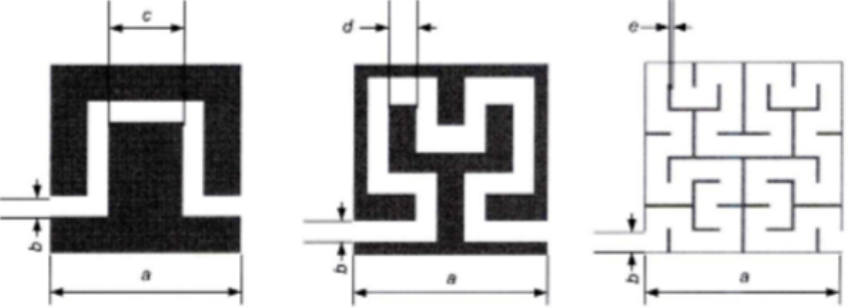
Figure 15. Space coiled acoustic metamaterials based on Hilbert fractals: first-order fractal, second-order fractal, and third-order fractal [55].